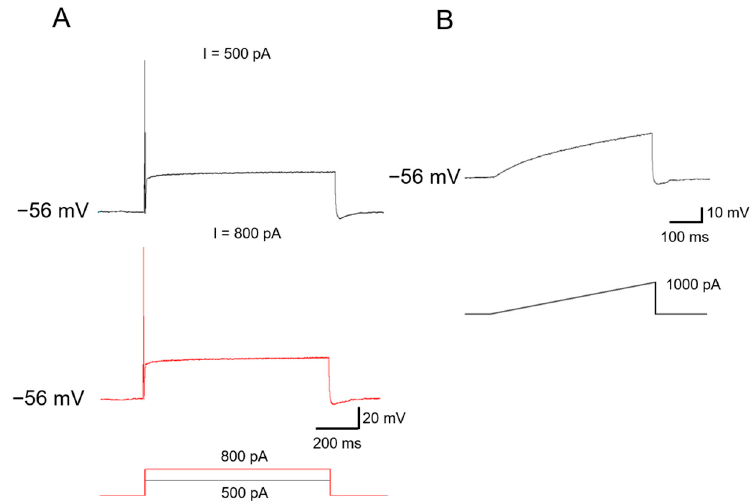
Figure 3. Typical examples of Class 3 neurons. ( A ) Typical recording traces showing that only one spike can be induced by depolarizing current steps ( n = 17); ( B ) In this class of neurons, no action potential was induced by current ramp injections. Note ( A , B ) were recorded from the same neuron.